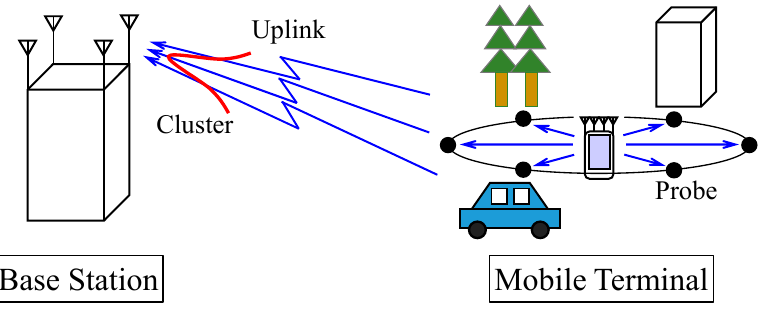
Figure 1. Propagation model for the uplink channel.